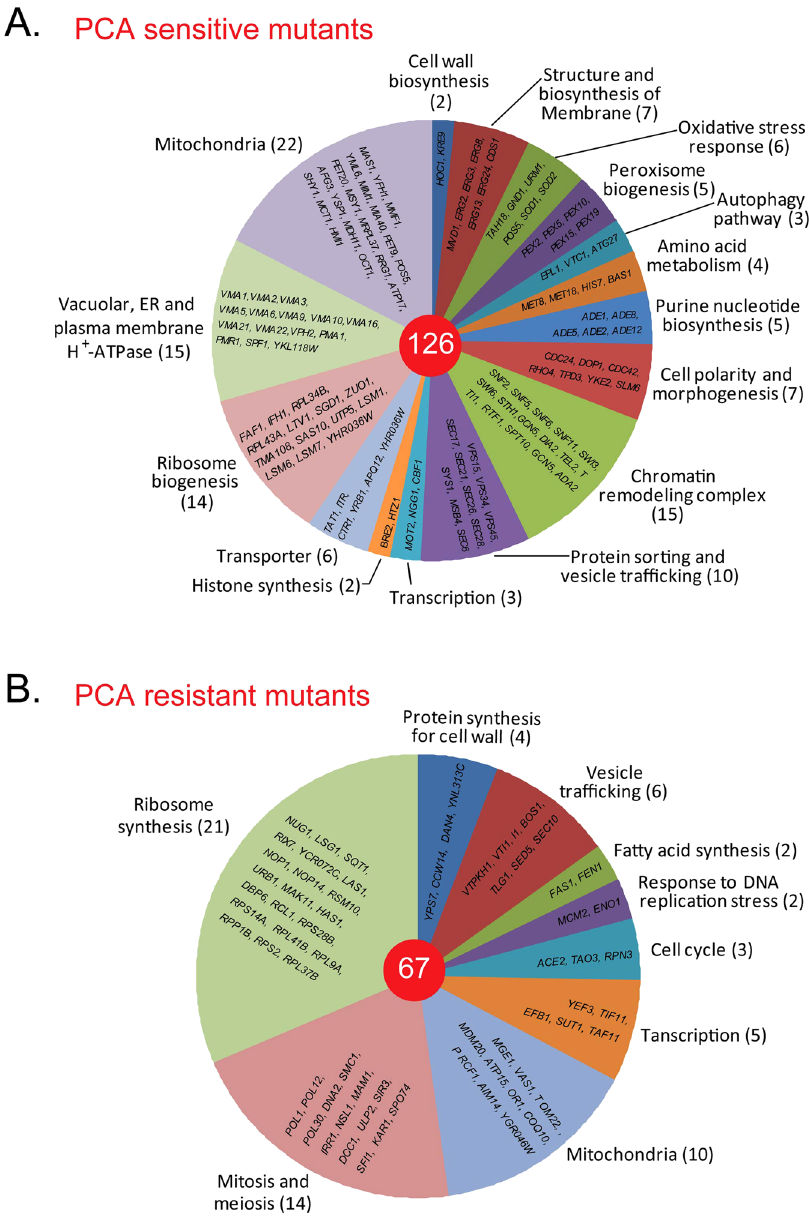
are presented as a pie chart, with the number of genes in parentheses. Detailed genes are listed on the pie. Total numbers of genes are listed in the red circle in the middle. ( B ) Saccharomyces cerevisiae mutants with increased resistance to PCA. Data are presented as in panel